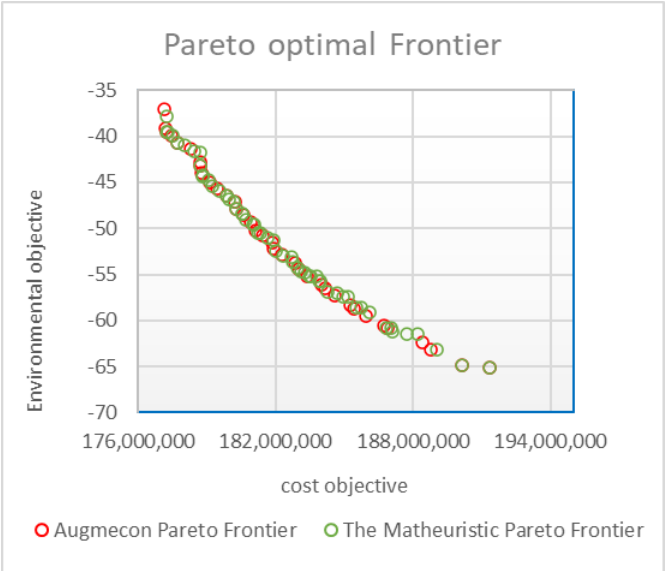
Figure 4. Comparison between the Pareto frontier of the AUGMECON and proposed matheuristic methods.